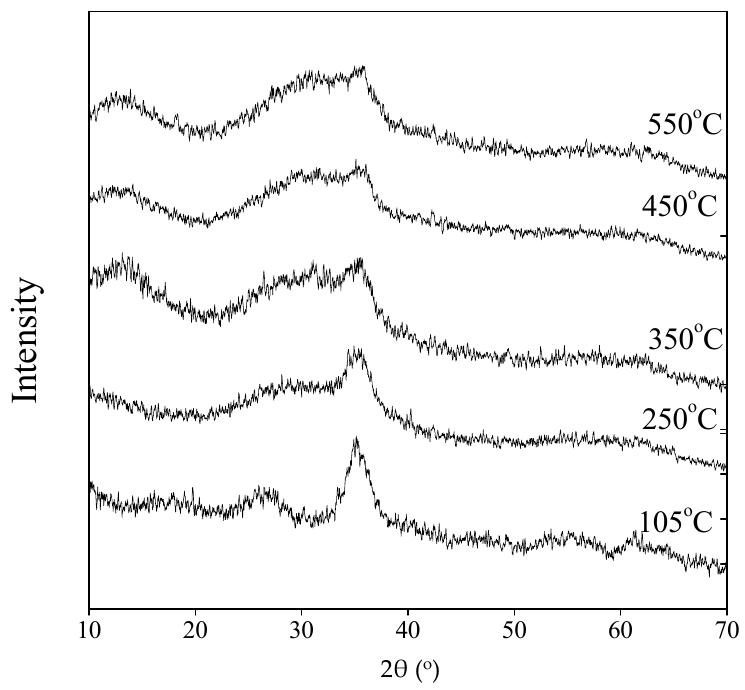
Figure 3. The X-ray diffraction (XRD) patterns of bio-schwertmannite before and after heating.